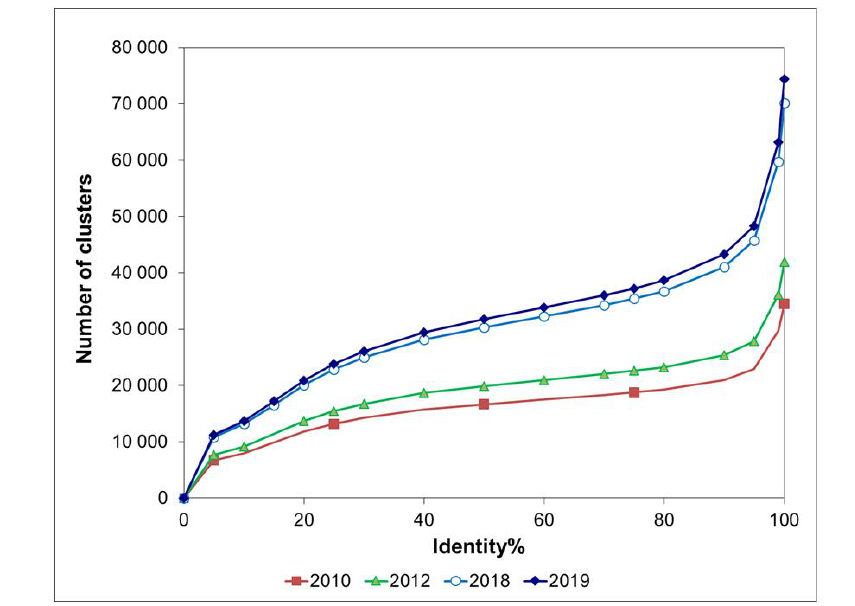
Figure 1. Dependence of the number of clusters on the identity between protein chains for the different years of Protein Data Bank (PDB) clusterization.